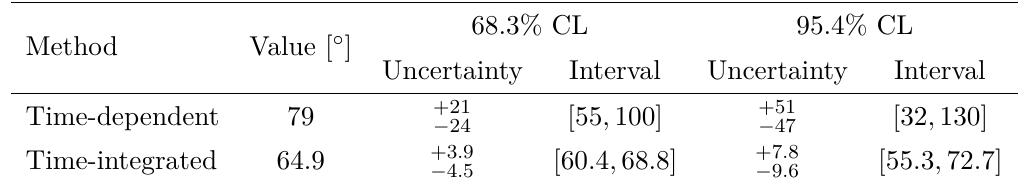
Table 5 . Confidence intervals and best-fit values for γ when splitting the combination inputs by time-dependent and time-integrated